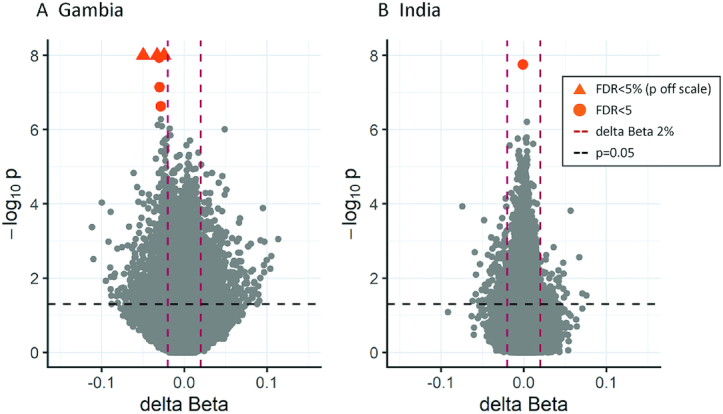
Volcano plots for each cohort of statistical significance against difference in methylation Beta values between intervention and control groups for all CpGs tested. Multiple linear regression models were used for an epigenome-wide association study in both Gambian (A: n = 289) and Indian (B: n = 686) cohorts. The dashed vertical and horizontal lines indicate thresholds for delta Beta 2% and nominal P = 0.05, respectively. Orange circles show differentially methylated positions—significant CpGs with false discovery rate (FDR) <5%; an orange triangle indicates a point falling outside the plot area.